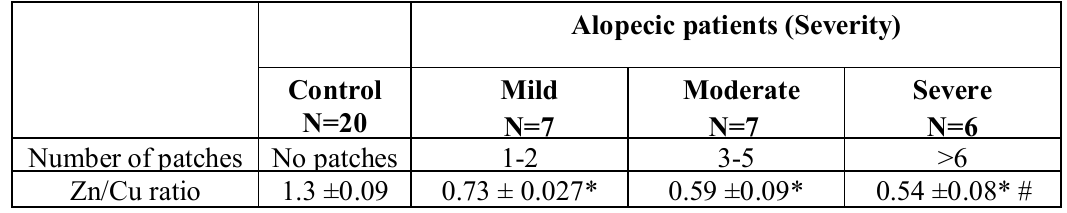
Table 2: Zn/Cu ratio in control subjects and patients with alopecia areata with